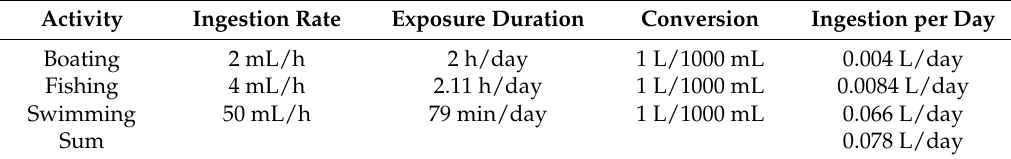
Table 3. Scenario 2—Recreational activity exposure